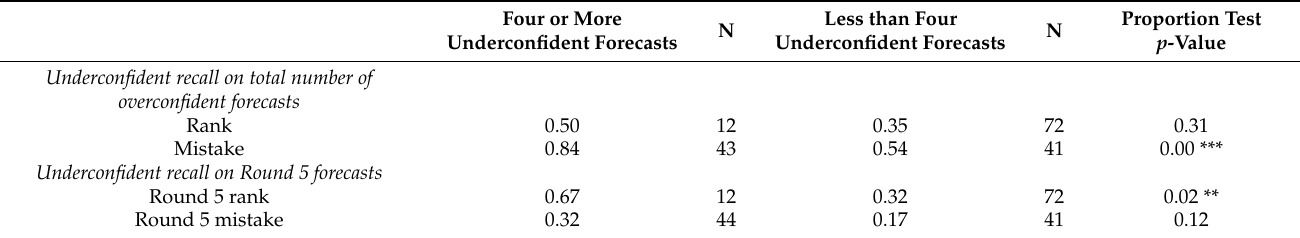
Table A3. Comparison of Underconfident Recall Conditional on Underconfidence in Forecasts. Four or More Underconfident Forecasts